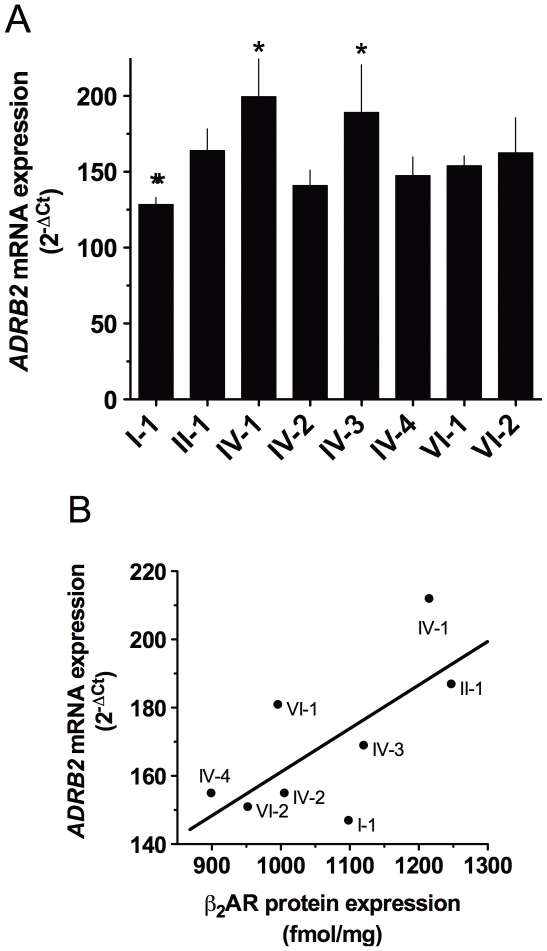

ADRB2 mRNA levels of the transfected β2AR haplotypes.(A) mRNA levels for haplotypes IV-1 and IV-3 are higher, and I-1 lower, than levels of the other haplotypes. Results are from 6 experiments. *, p<0.05 vs. the other haplotypes. (B) relationship between ADRB2 mRNA levels and β2AR protein expression. The r2 for this relationship was 0.47. Two haplotypes (VI-1 and I-1) are greater than 1 standard deviation from the mean β2AR/ADRB2 ratio.